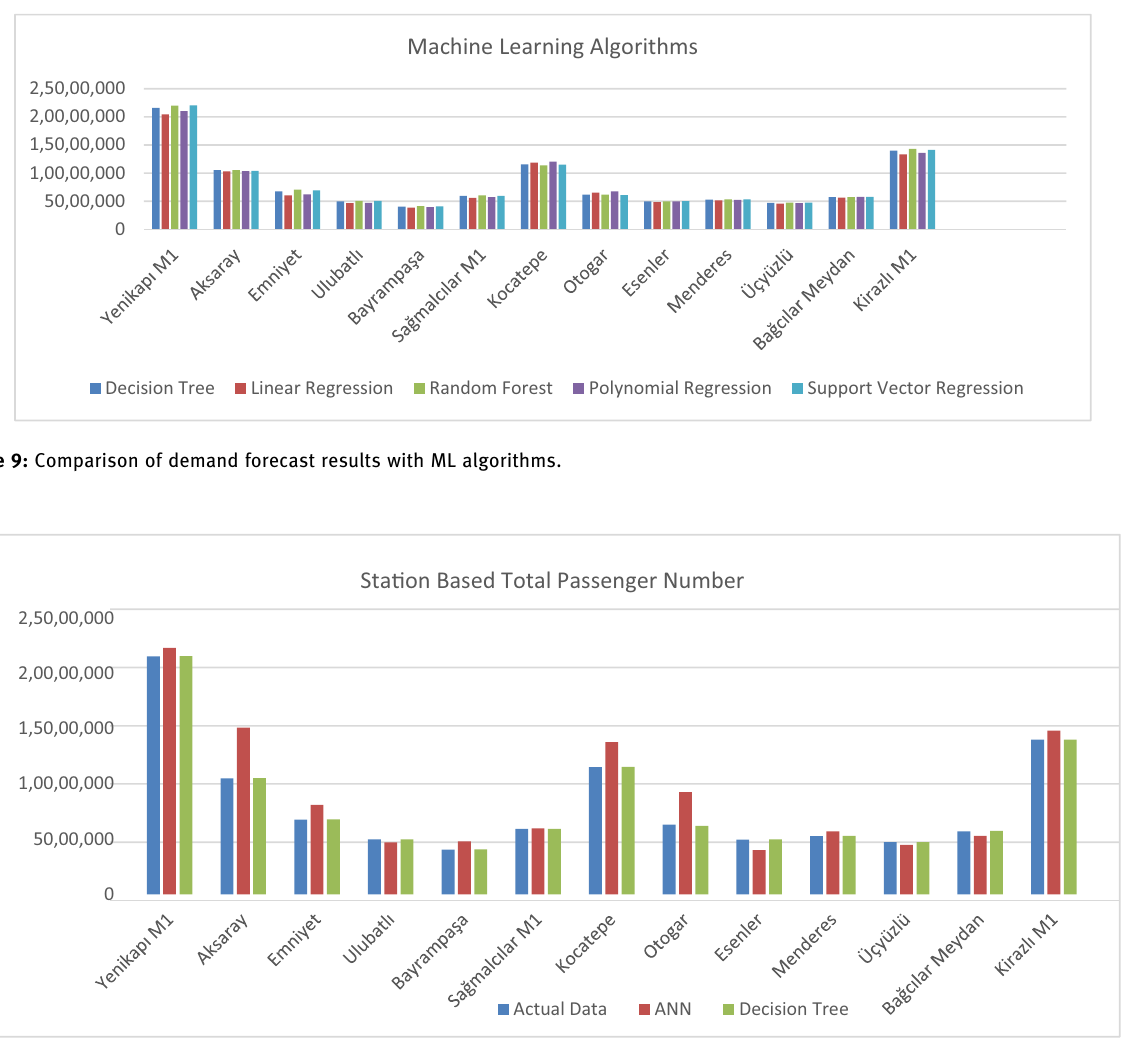
Figure 10: Comparison of the demand forecast results of decision tree and